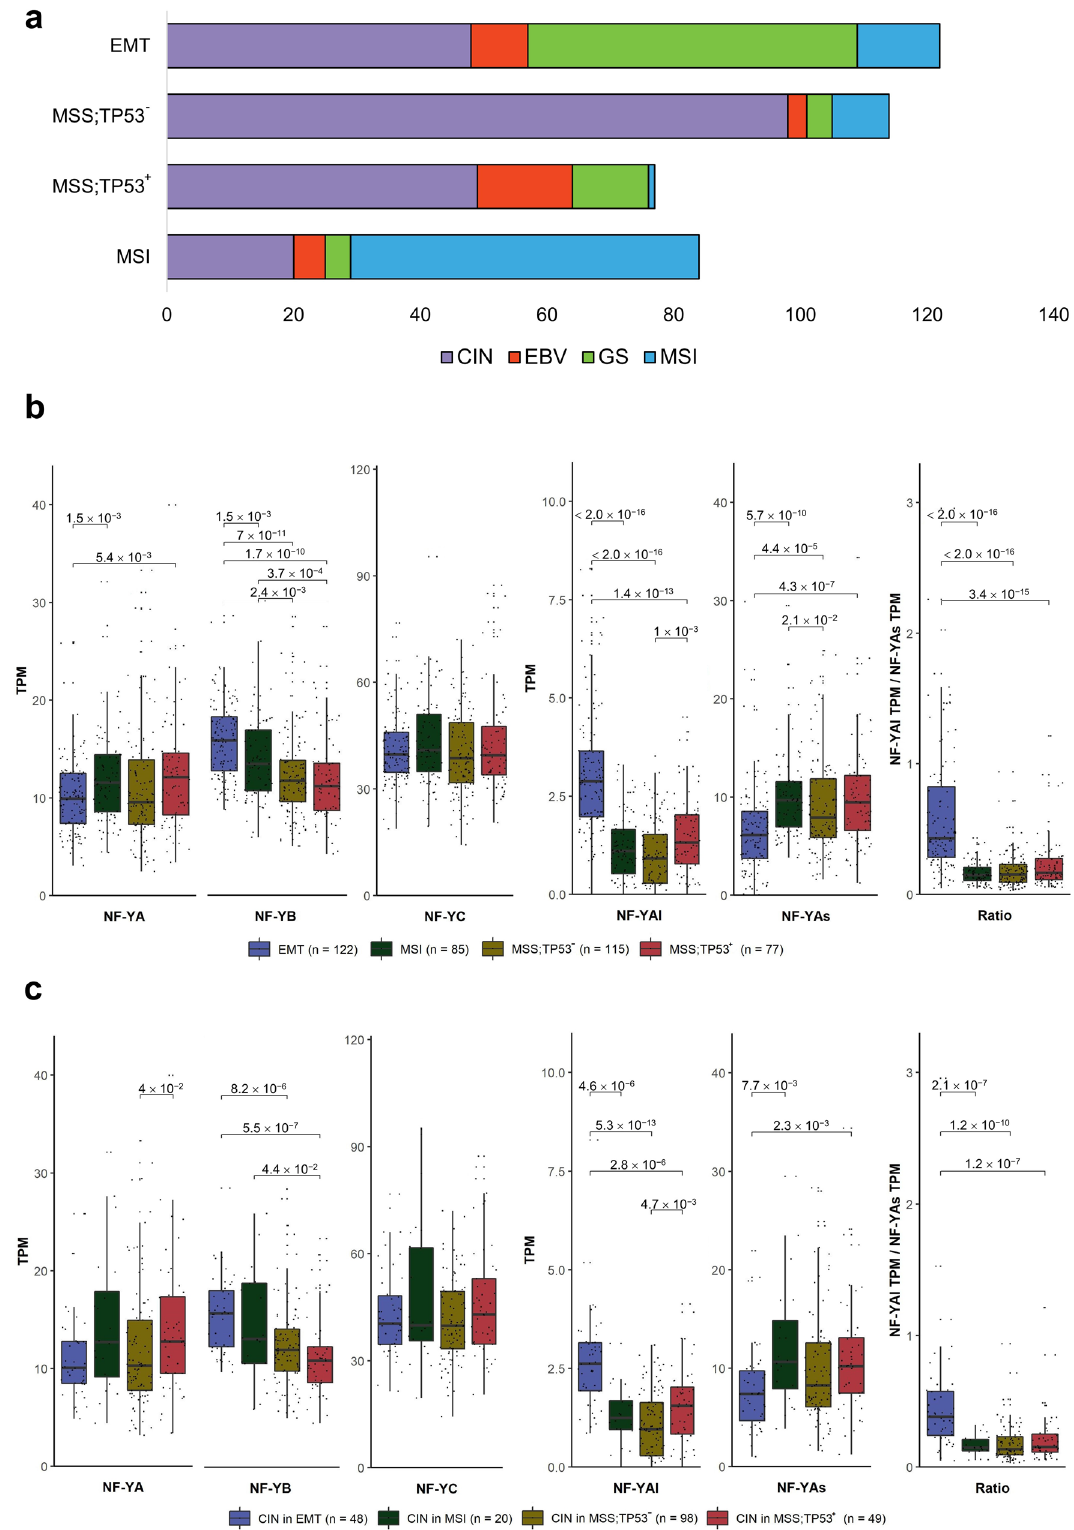
Figure 5. NF-Y expression in the ACRG subtypes. ( a ) Partitioning of TCGA subtypes in the four ACRG subtypes, according to the classification of TCGA RNA-seq dataset. ( b ) Box plot analysis of NF-Y subunits (Left Panel) and NF-YA isoforms (Right Panel) in the four ACRG subtypes. ( c ) Same as ( b ), except that expression was computed in the TCGA CIN samples partitioned in the ACRG subtypes. p values are calculated using the Wilcoxon rank-sum